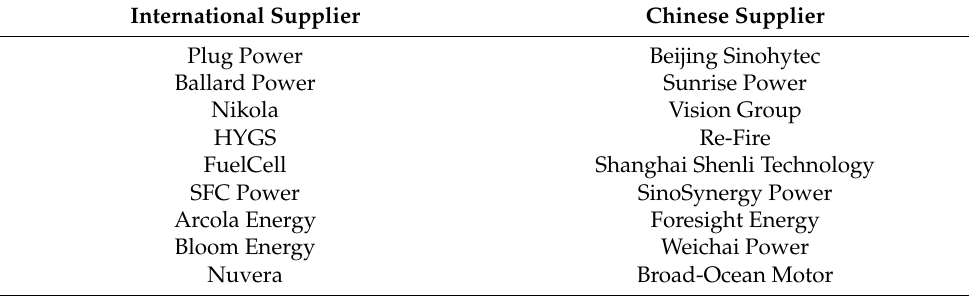
Table 5. Fuel cell suppliers in the Chinese market. Data retrieved from [108,109]. International